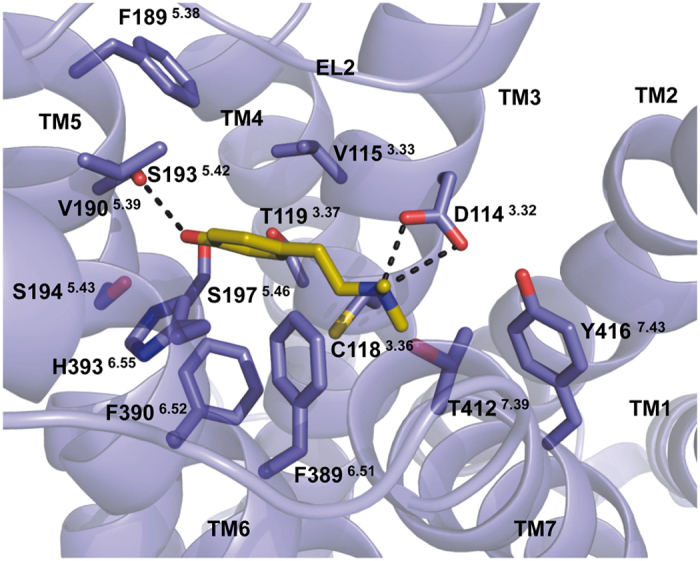
Conformation of hordenine and its receptor-ligand interactions obtained after docking and energy minimisation.We used an active-state homology model of D2R and performed MD simulations with the endogenous ligand dopamine42. Dopamine was removed from the model, hordenine was docked into the binding pocket and the resulting receptor-ligand complex was subjected to energy minimisation in a water box. Whereas dopamine is able to form two hydrogen bonds with both Ser1935.42 and Ser1975.46 in the D2UpR model42, our VS hit hordenine forms only a single hydrogen bond to Ser1975.46 due to the lack of a second hydroxyl group.